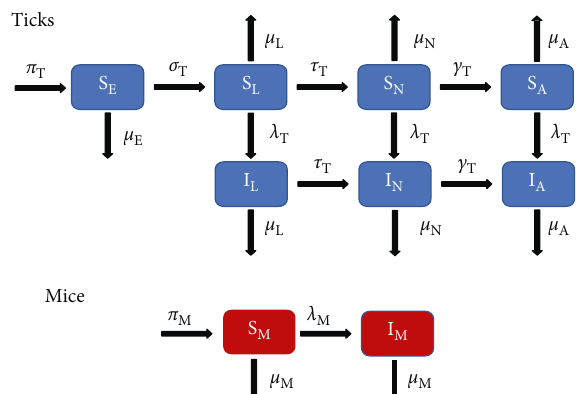
Figure 1: Flow diagram of the Lyme disease model for ticks and mice. The mice population is represented by the red boxes and is divided into susceptible ( S M ( t )) and infected ( I M ( t )) compartments. The tick population is represented by the blue boxes and is divided by life stage and infection status. It consists of susceptible eggs ( S E ( t )) , susceptible larvae ( S L ( t )) , infected larvae ( I L ( t )) , susceptible nymphs ( S N ( t )) , infected nymphs ( I N ( t )) , susceptible adults ( S A ( t )) , and infected adults ( I A ( t ))